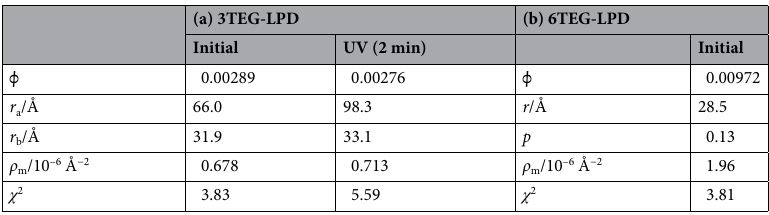
Table 2. SANS profiles with fitting results, after UV irradiation and standing in the dark, of 5.0 mM 3TEG- LPD (a) and 6TEG-LPD (b) solutions saturated with calcein. Prolate ellipsoids for 3TEG-LPD and spheres with a Schultz size distribution for 6TEG-LPD were